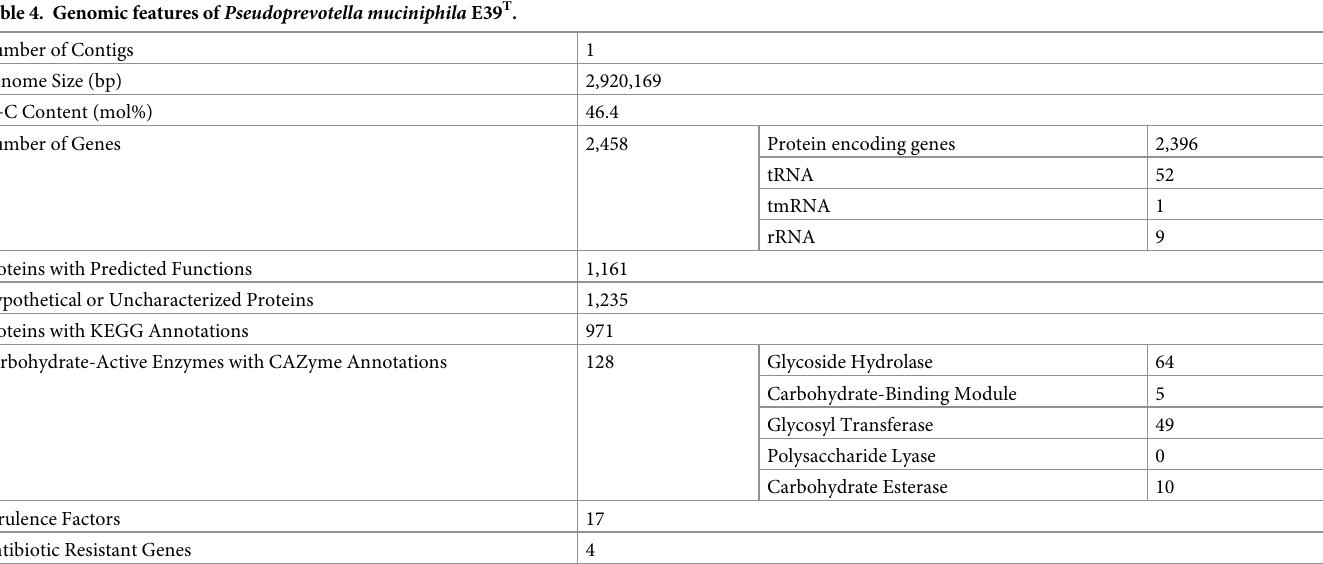
Table 4. Genomic features of Pseudoprevotella muciniphila E39 T